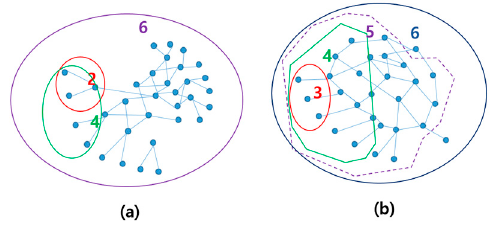
Figure 1. Random Graph of ( a ) Fat-free ( b ) Jellyfish.